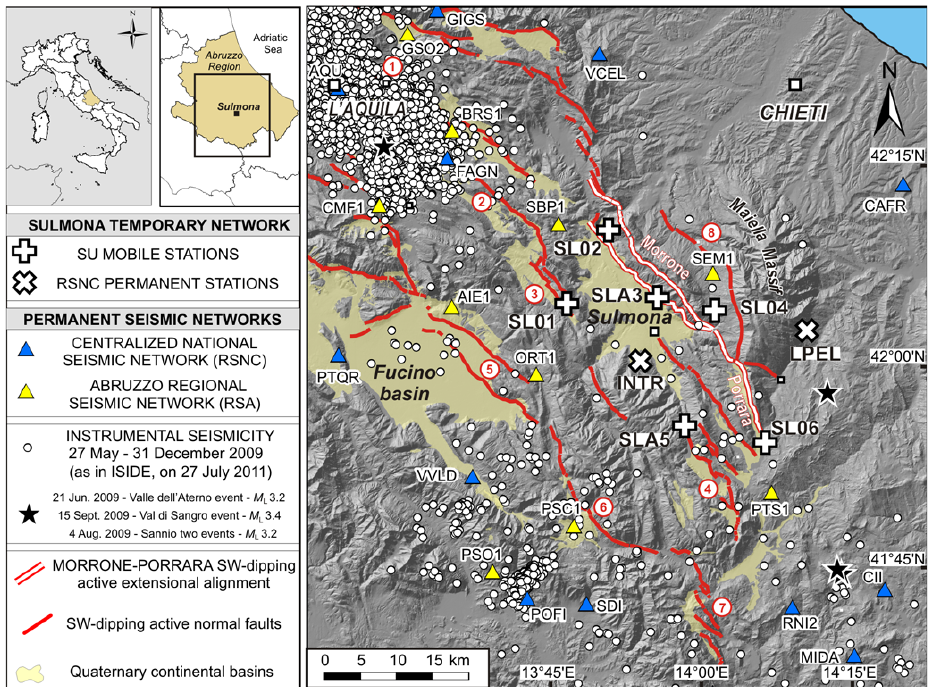
Fig. 1. Station locations and epicentral distribution of seismic events recorded by the INGV National Seismic Network (RSNC, http://iside. rm.ingv.it/iside/standard/index.jsp) in the Sulmona area (Abruzzo region) during the period 27 May–31 December 2009. The black stars indicate the epicentres of the strongest events located in this study; these are listed in the legend, from north to south. SU stations are labelled by pluses; crosses show the two permanent stations of the RSNC acquired in continuous recording mode and treated offline as data exchange. Selected permanent stations of the RNSC and of the Abruzzo Regional Seismic Network (RSA; see De Luca, 2011) were used in this study and are marked by blue and yellow triangles, respectively. The red numbers correspond to fault systems cited in the